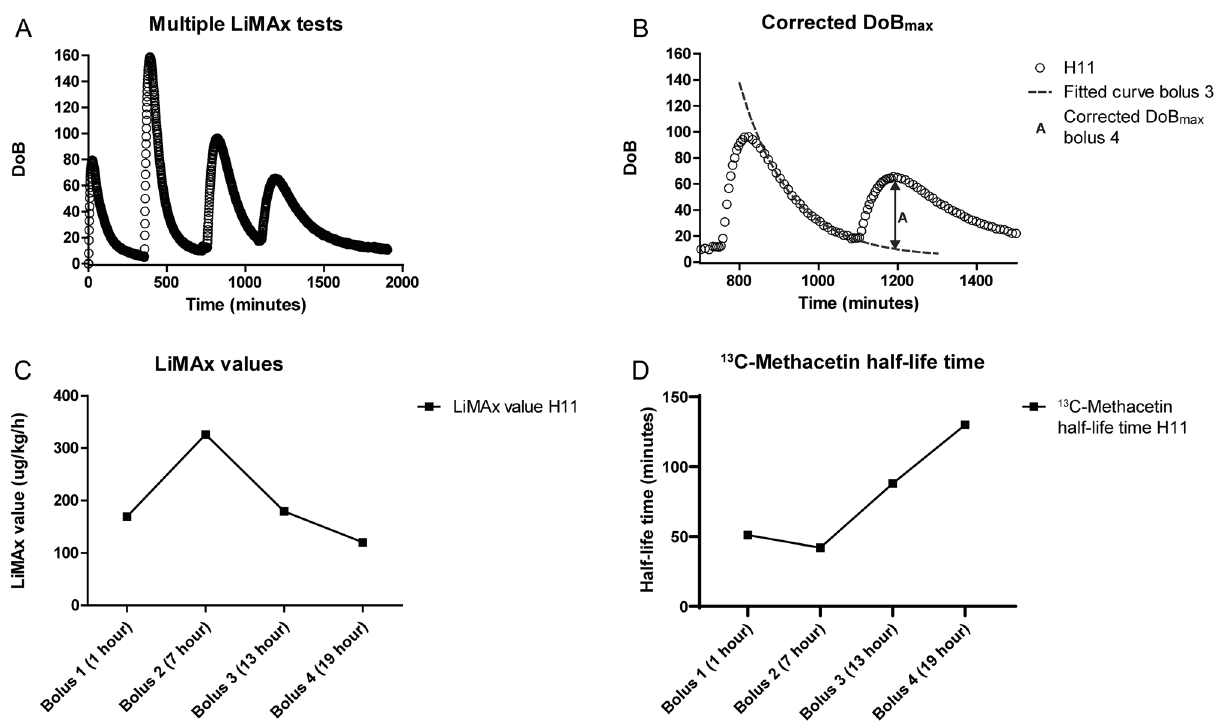
Figure 4. Consecutive LiMAx testing during normothermic machine perfusion. ( A ) Four sequentially repeated LiMAx tests over a period of 30 h of liver H11 were performed. Every 6 h, a new bolus methacetin was injected, resulting in a new DoB peak. ( B ) Before administering a new bolus, the DoB has not returned to the baseline, which should be corrected. The corrected DoB max is made by calculating the remnant DoB of the previous bolus of 13 C-methacetin and subtracting this from the new DoB max. . ( C ) This illustrates the different LiMAx values in time during long-term machine perfusion. ( D ) This presents the different 13 C-Methacetin half-life time during long-term machine